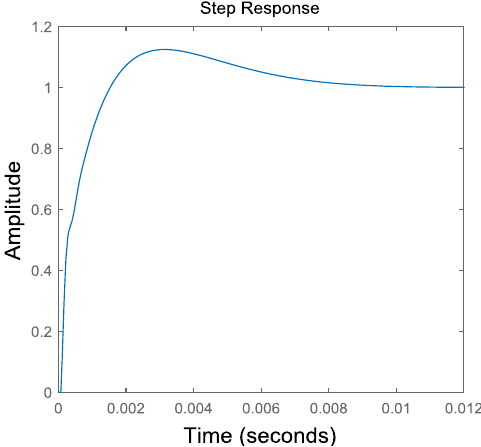
Figure 19. Step response of voltage closed-loop transfer function with set 2.